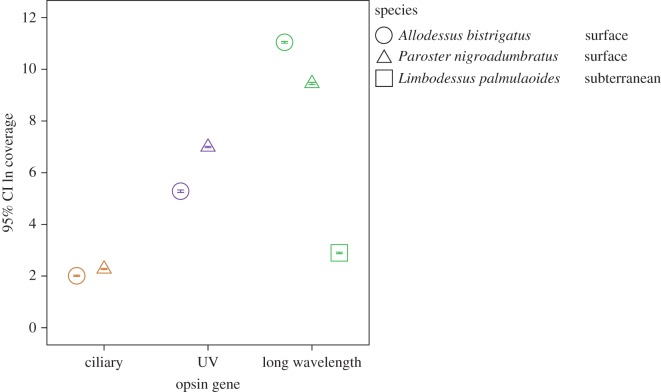
Relative sequence coverage depth for identified opsin orthologues. Mean sequence coverage depth is plotted on a lognormal scale. The relative coverage is indicated for each of the seven indentified opsin orthologues for surface (A. bistrigatus, circle; P. niogroadumbratus, triangle) and subterranean (L. palmulaoides, square) species. Opsin copy is identified by colour: ciliary-type (brown), UV (violet) and long wavelength (green).